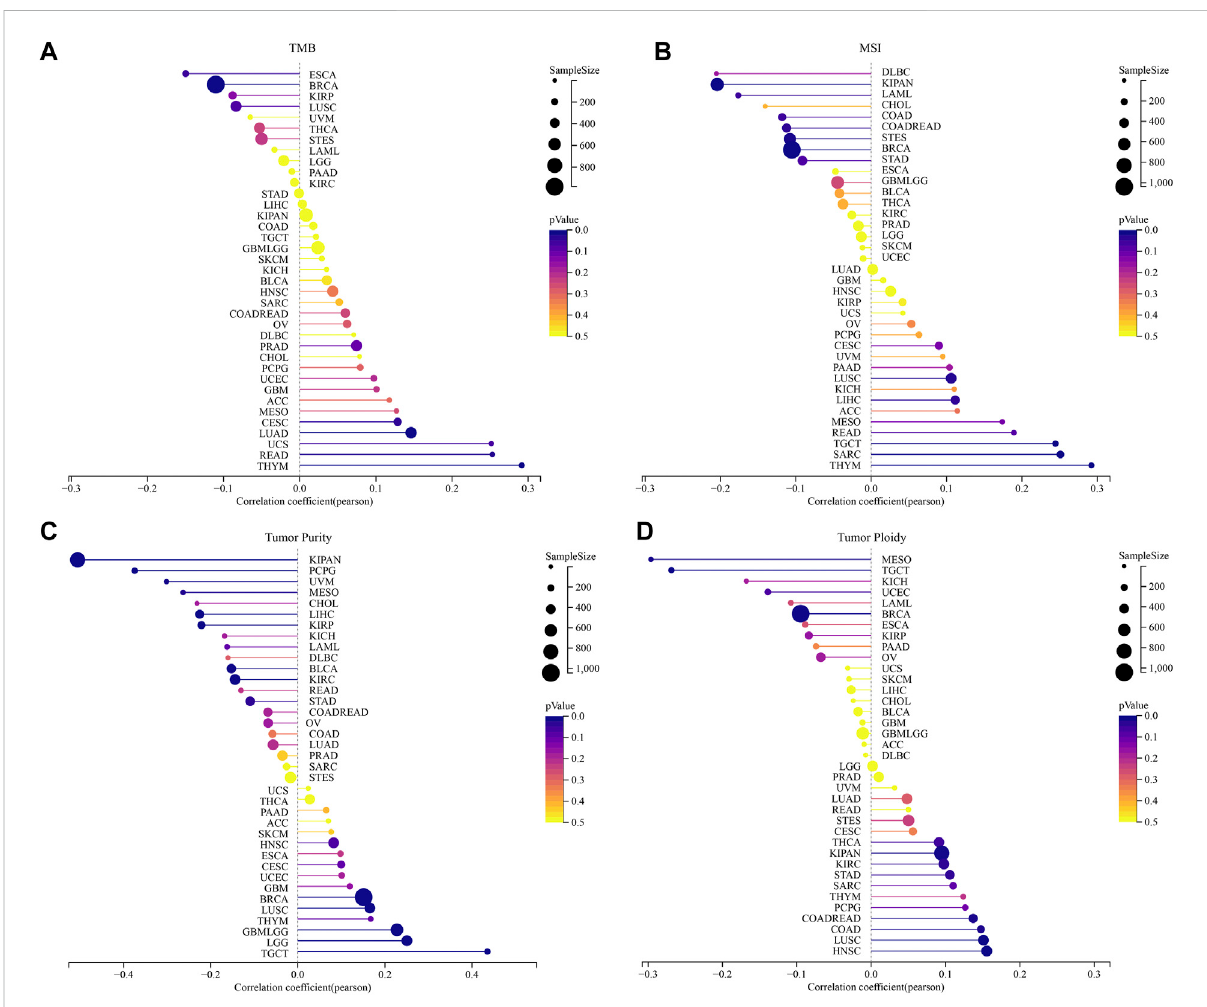
FIGURE 10 Correlation between the STC2 Expression and tumor heterogeneity. (A) Correlations between STC2 expression and TMB; (B) Correlations between STC2 expression and MSI; (C) Correlations between STC2 expression and tumor purity; (D) Correlations between STC2 expression and